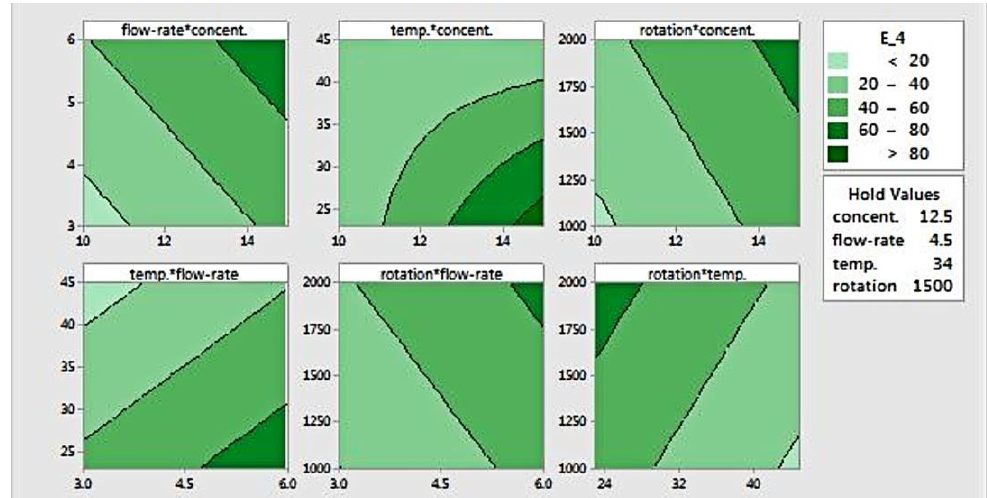
Figure 5. Contour plot for modulus elasticity.